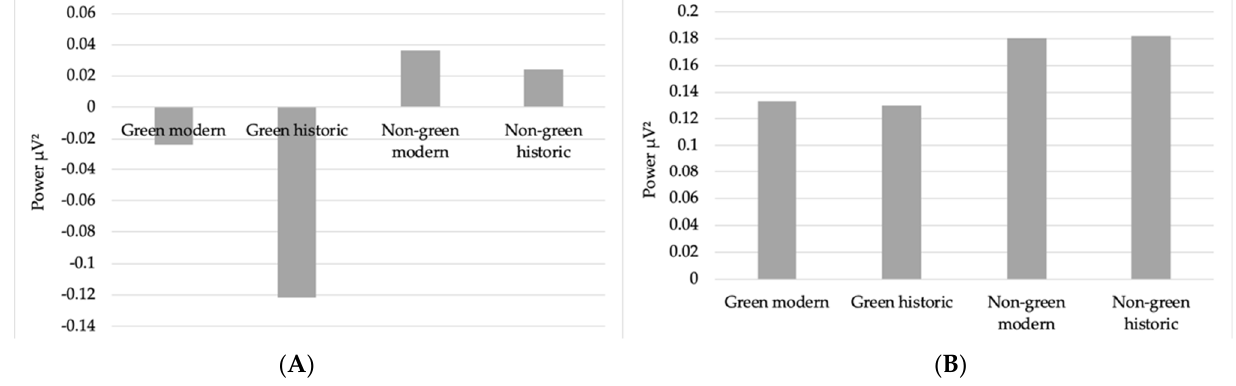
Figure 4. Mean occipital alpha ( A ) and theta ( B ) power across environments. For theta power, there were significant differences for occipital ( F (2.09, 60.69) = 5.65, p = 0.005, η 2 p = 0.16), lateral ( F (3, 87)= 17.21, p < 0.001, η 2 p = 0.37), left ( F (3, 87) = 7.22, p < 0.001, η 2 p = 0.20), and right frontal ( F (3, 87) = 6.47, p = 0.001, η 2 p = 0.18) regions of the brain. For occipital regions, theta power was reduced for green modern (M = 0.133, SD = 0.22) and green historic (M = 0.130, SD = 0.21) environments, with green historic being the low- est (see Figure 4). For lateral frontal regions, green historic (M = 0.40, SD = 0.21) and non- green modern (M = 0.39, SD = 0.22) environments showed the lowest levels of theta power. For left frontal, there was reduced theta power for the non-green modern environment (M = 0.27, SD = 0.19), and for right frontal, the green historic environment had the lowest theta power (M = 0.22, SD = 0.17). 4. Discussion The current study assessed the impact of exposure to green and historic urban envi- ronments on mental well-being with a combination of self-reported psychological and physiological (EEG) measures. The research questions that were posed were: (1) Does ex- posure to urban environments with green and historic elements, and their combination, benefit mental well-being? (2) Do psychometric and physiological measurements agree when assessing the well-being benefits of exposure to different urban environments? Descriptive analyses of subjective measures showed that exposure to all four non- traffic urban environments contributed to the recuperation of mental well-being after ex- posure to the traffic environment and that their restorative potential was comparable. However, among the four environments, the presence of historic elements was associated with a significantly stronger recuperation in hedonic tone and reduction in stress. This may provide evidence that exposure to historic elements is more beneficial than exposure to modern environments. In terms of mental well-being, historic elements can support mental well-being states, and these findings help to answer our first research question. The effect of historic environments supports and extends previous research which has shown the restorative potential of historic environments [17,29,32,38,44]. Our results found greenness to not be a significant predictor of subjective well-being. This could be related to the fact that according to descriptive checks, more focus was placed on historic features even when greenness was present. The most popular de- scriptors chosen for the environments shown were more focused on the historic charac- teristics rather than the green elements, even when greenness was present (e.g., ‘historic’, ‘old’). However, when participants viewed the green environments which lacked historic features, descriptors were chosen that were more focused towards greenness. This sug- gests that more focus was placed on historic features even when greenness was present, which supports the subjective findings that the main effect was from historic, as per our first research question. Also, it shows that greenness is potentially valued or noticed more in the absence of historic characteristics. However, regarding preferences for